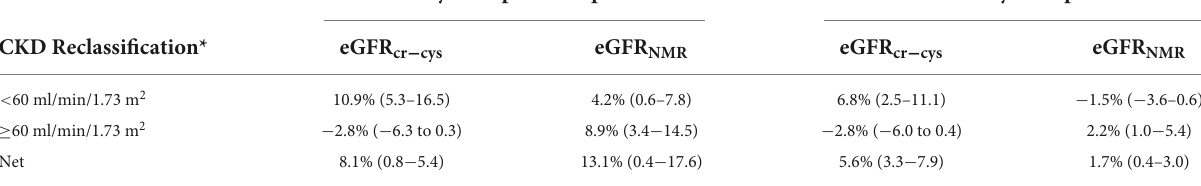
TABLE 3 Reclassification of patients into correct measured GFR clinical